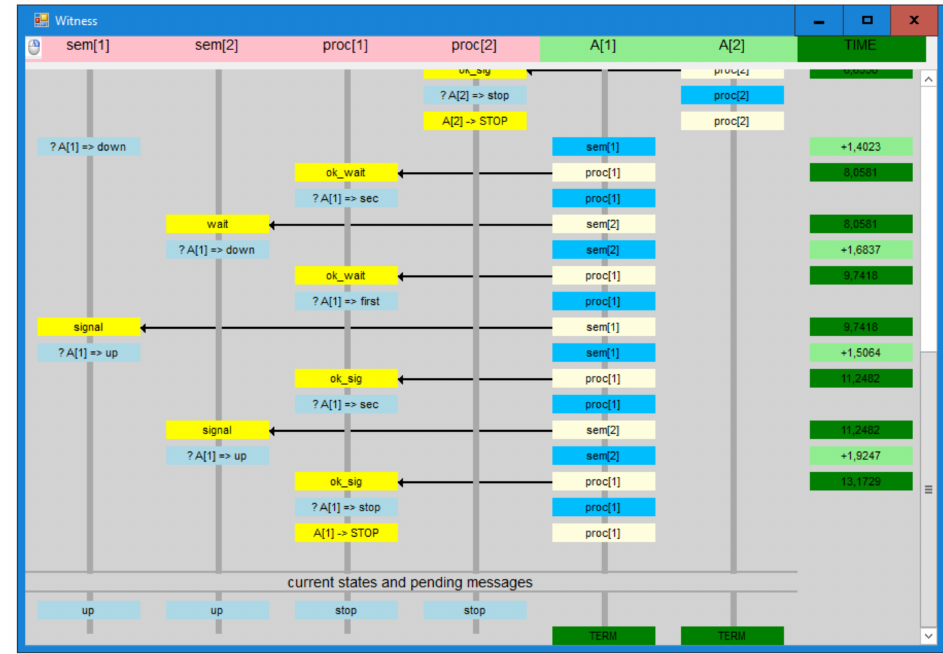
Figure 9. A witness showing a termination of both agents in timed two semaphores .